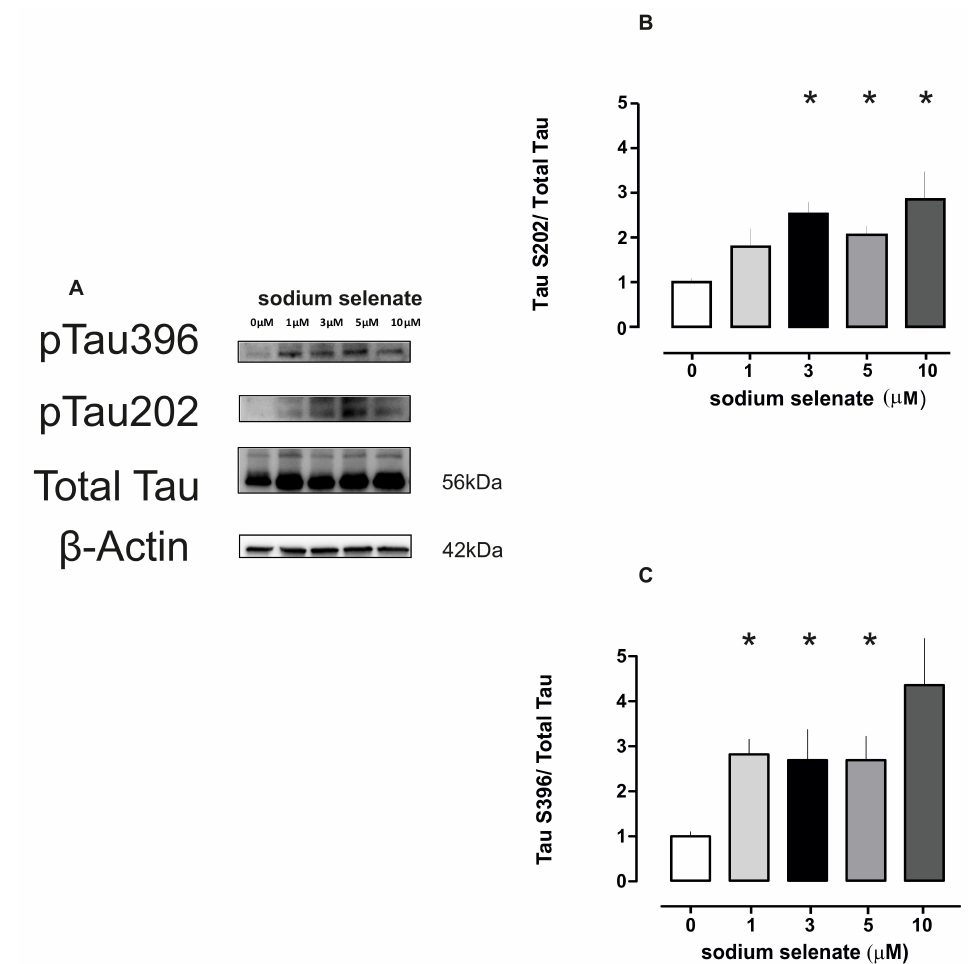
Figure 4. Sodium selenate treatment enhances total Tau and phosphorylation of two disease marker epitopes AT8 and PHF1 in a dose responsive manner. ( A ) Immunoblot images of Total Tau (56 kDa) and phosphorylated S202 (pTau202) and S396 (pTau396) epitopes for the different sodium selenate doses, loading control β -actin as above (not shown). ( B , C ) Histogram plots of pTauS202 and pTau396 after different selenate doses (asterisk p <